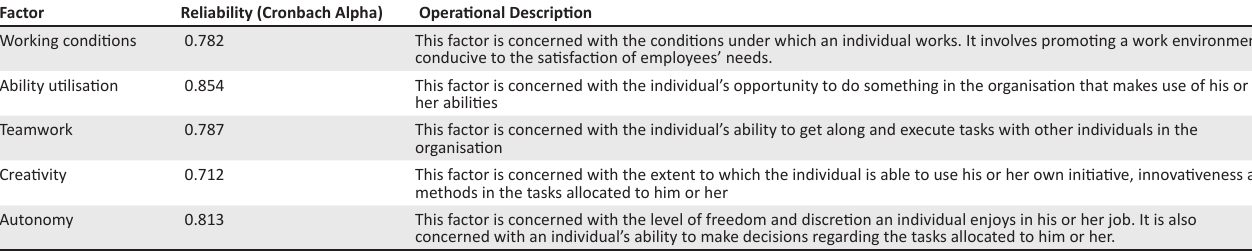
TABLE 2: Internal consistency estimates (Cronbach alpha) and operational definitions for employee satisfaction sub-scales. Factor Reliability (Cronbach Alpha)